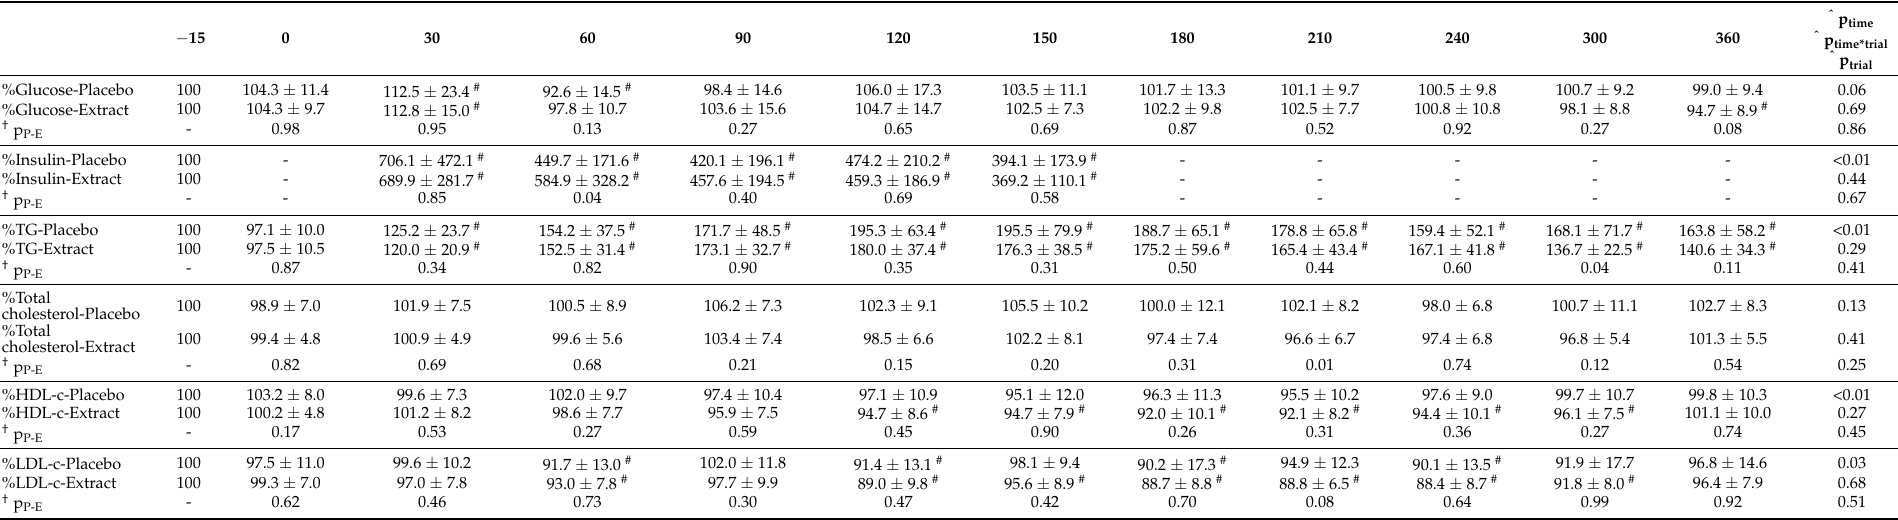
Table 4. Percentage of change in basic biochemical markers in the two intervention